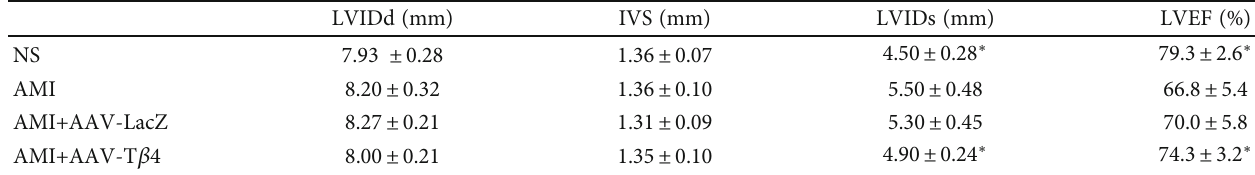
Table 2: AAV-T β 4 alleviates increases in MDA content and MPO activity in heart